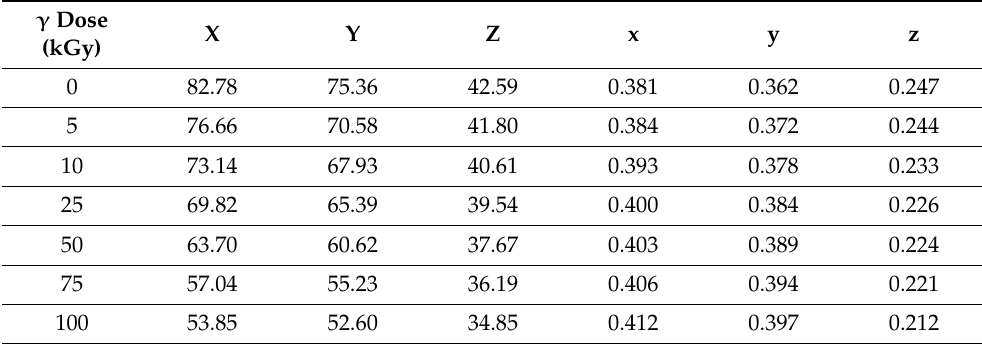
Table 2. The tristimulus values (X, Y, Z) and chromaticity coordinates (x, y, z) of the PVA-Lg/Pd NC samples against γ